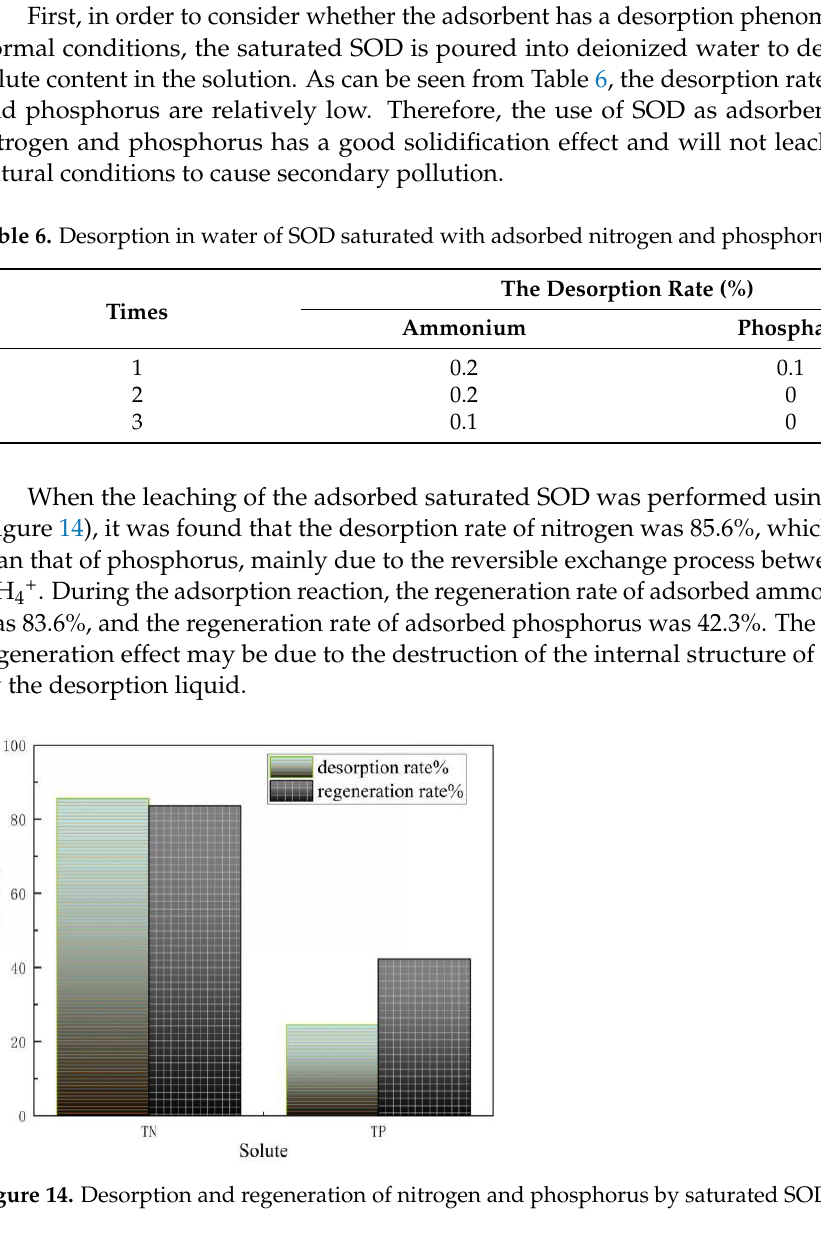
Table 6. Desorption in water of SOD saturated with adsorbed nitrogen and phosphorus.